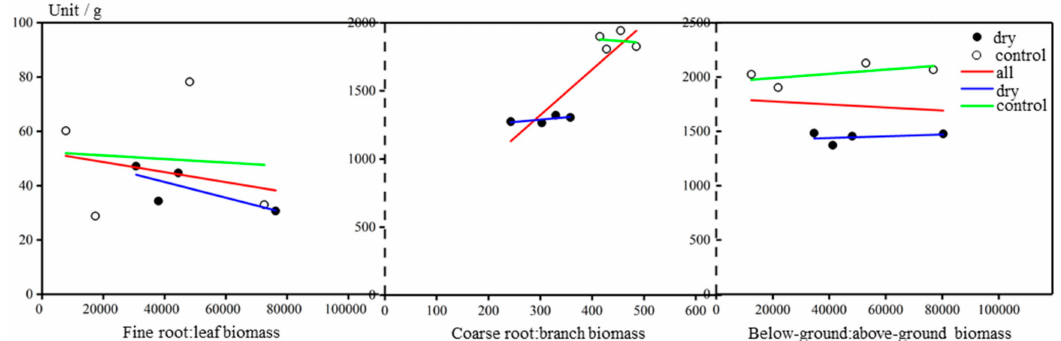
Figure 6. Three types of root:shoot ratio: fine root:leaf biomass ratio, coarse root:branch biomass ratio and below-ground:above-ground biomass ratio. White circles represent the control group, and black circles represent the dry-treatment group. Red, green and blue lines are the fitting regressions for all trees, the control group and the dry-treatment group, respectively.